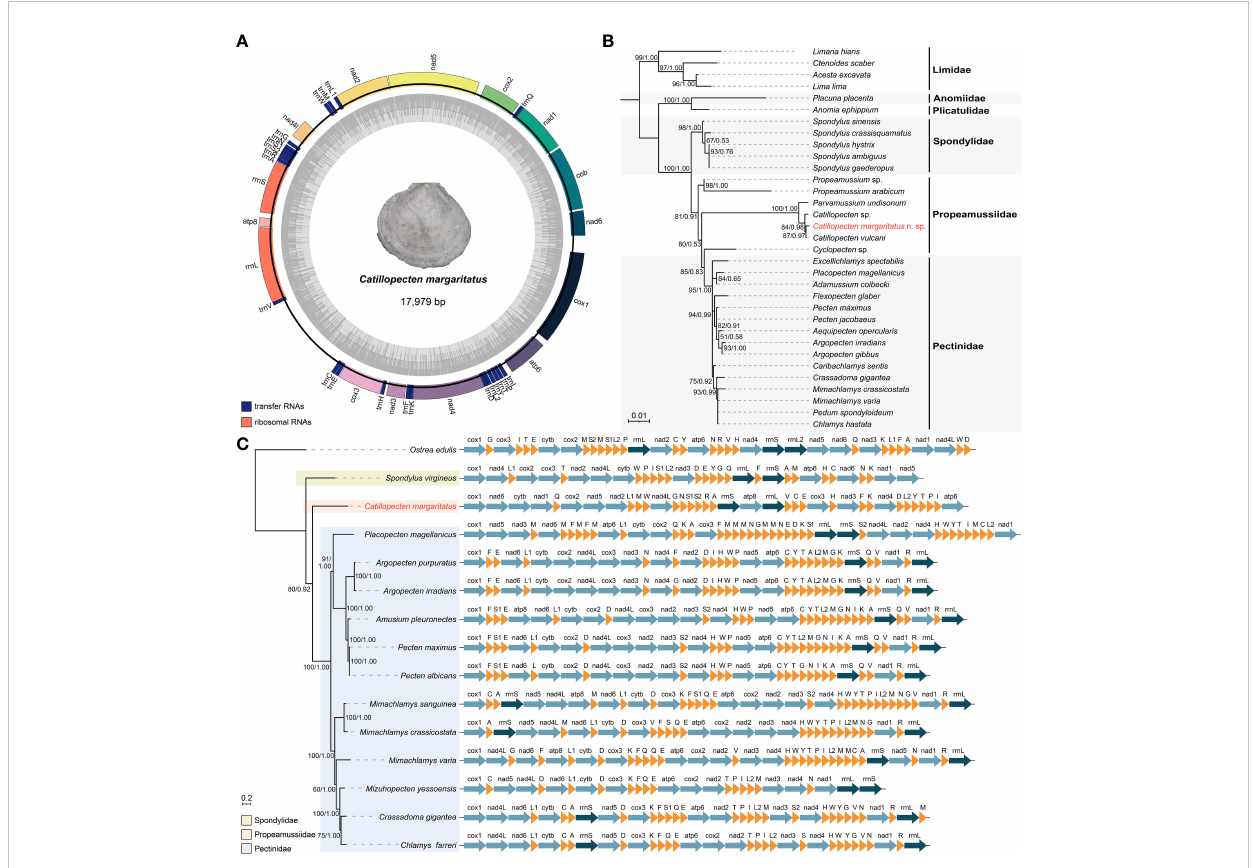
FIGURE 5 Mitogenome features of Catillopecten margaritatus n. sp. and its phylogenetic position. (A) Mitogenomic gene orders and relative lengths. (B) Phylogenetic tree of the order Pectinida based on 1 8S rRNA fragments. The topology is based on BI analysis, with Limidae as the outgroup. The accession numbers are presented in Table S1. (C) Mitogenomic phylogenetic tree based on protein coding genes and rRNAs and the mitochondrial gene arrangements of the superfamily Pectinidea species. The topology is based on BI analysis, with Ostrea edulis as the outgroup. Posterior probabilities values (>0.50) from BI analysis and bootstraps values (>50) from the ML analysis are given at the